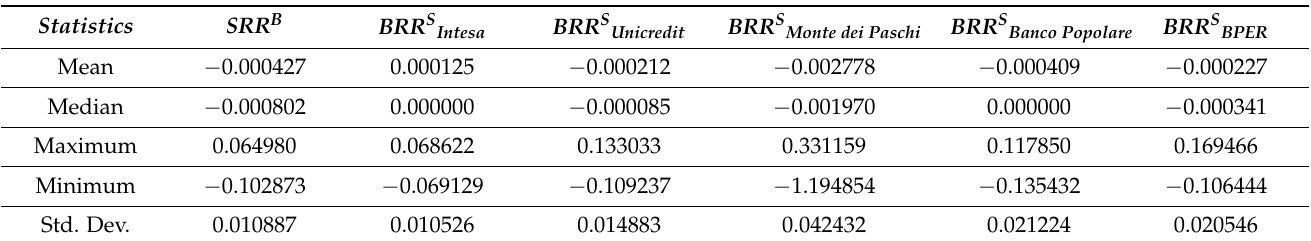
Table 1. Descriptive statistics of SRR B and BRR S data: January 2015 to December 2021 (1827